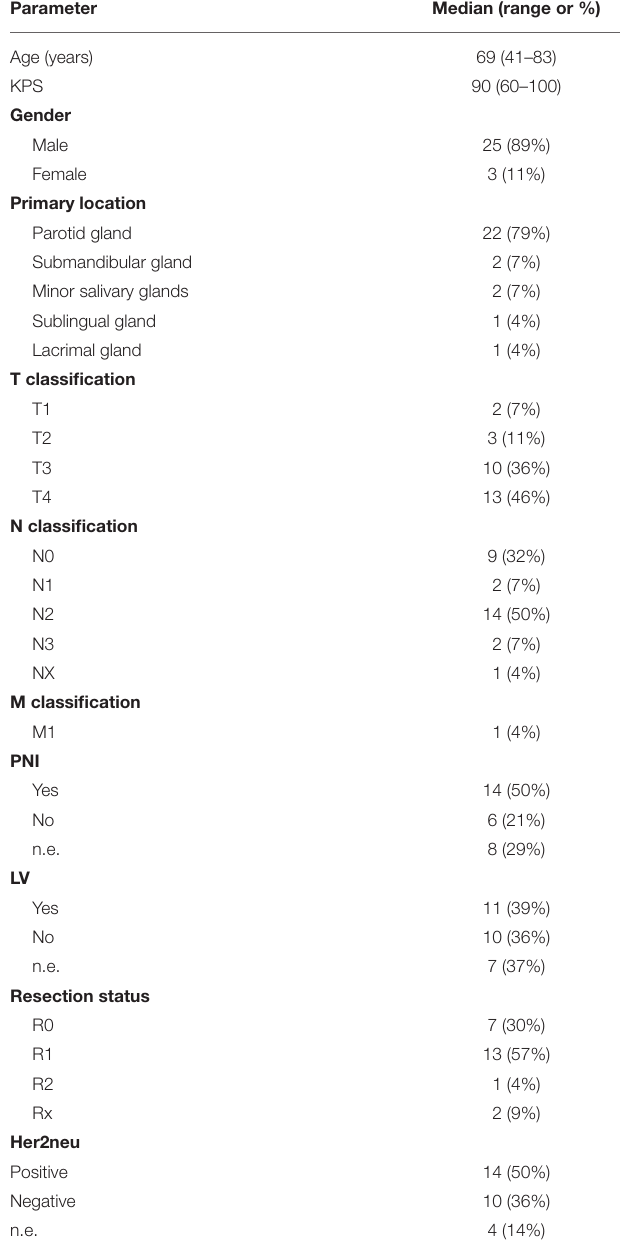
TABLE 1 | Clinical characteristics of the study cohort ( n = 28).